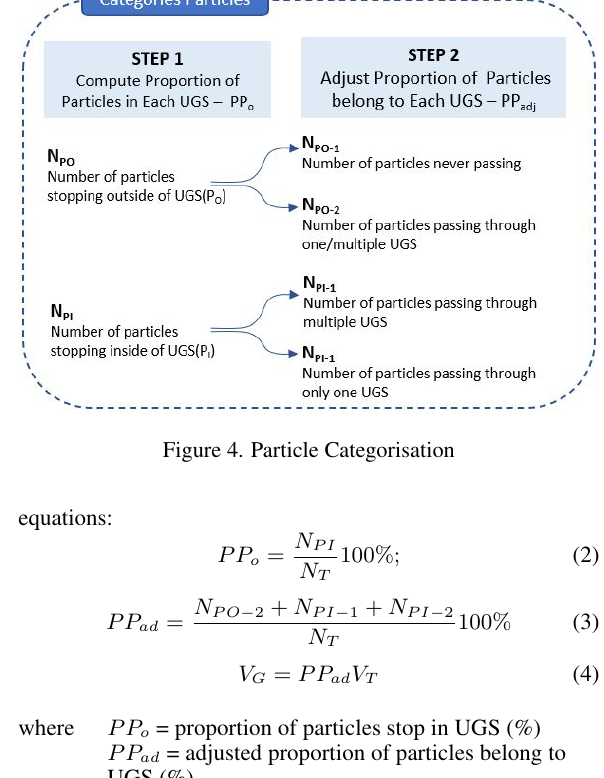
Figure 4. Particle